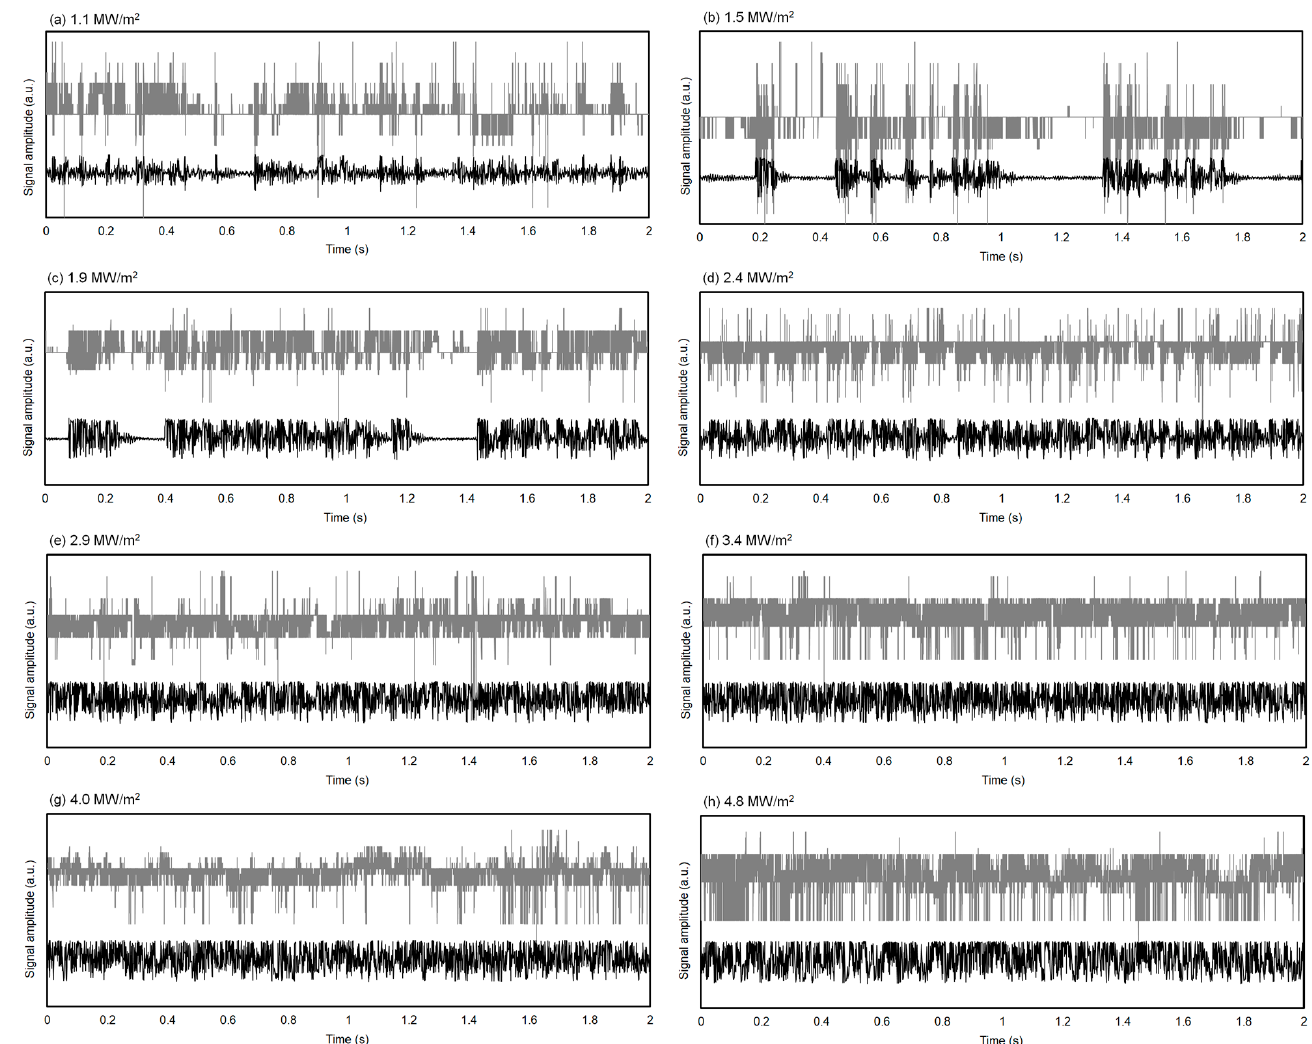
Figure 5. Signals obtained using the synchronized signal with the front high-speed camera (grey lines) and the hydrophone (black lines). The signals were acquired at heat fluxes of ( a ) 1.1 MW/m 2 , ( b ) 1.5 MW/m 2 , ( c ) 1.9 MW/m 2 , ( d ) 2.4 MW/m 2 , ( e ) 2.9 MW/m 2 , ( f ) 3.4 MW/m 2 , ( g ) 4.0 MW/m 2 , and ( h ) 4.8 MW/m 2 .